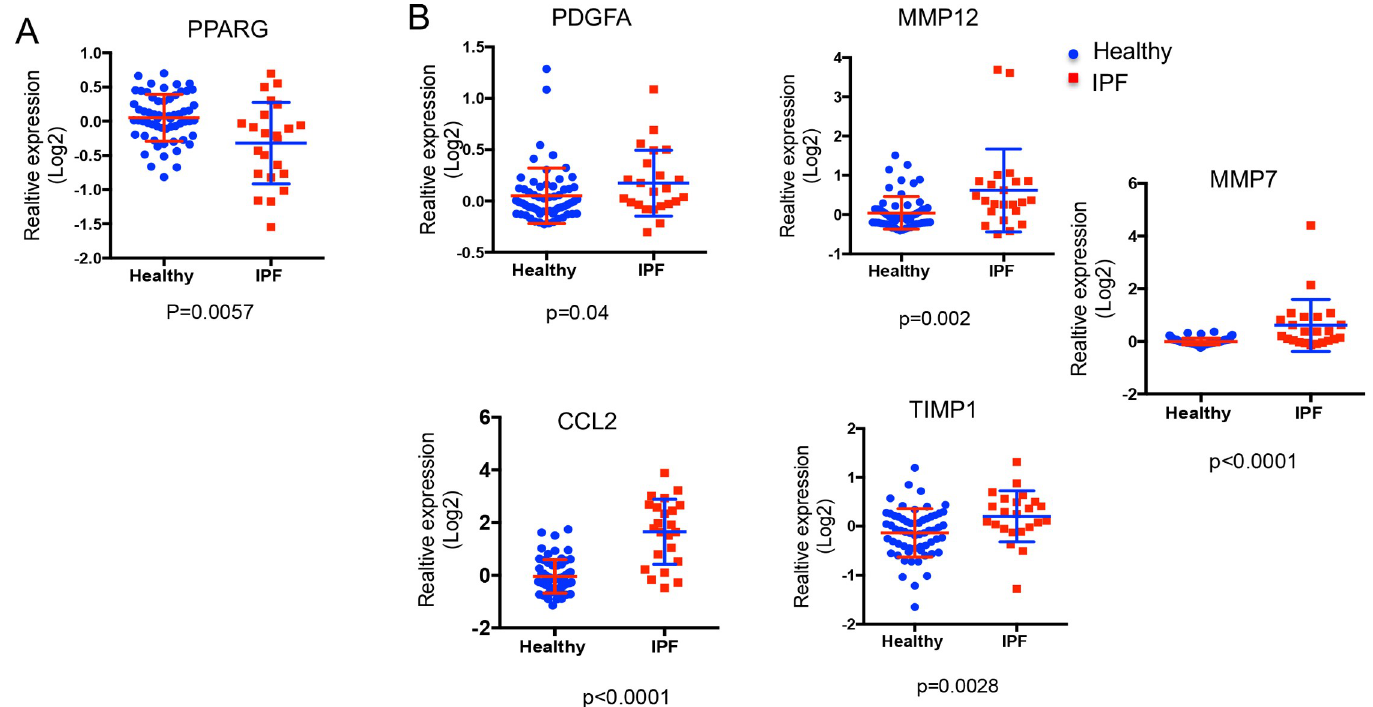
Fig 3. Macrophages from human pulmonary fibrosis patients exhibited diminished PPARG and dysregulated pro-inflammatory and pro-fibrotic gene expression. PPARG, pro-inflammatory and pro-fibrotic gene expression in lung macrophages isolated from 61 healthy volunteers or 23 pulmonary fibrosis patients in the GSE49072 microarray datasets. ( A ) PPARG expression in lung alveolar macrophages from healthy or pulmonary fibrosis patients. ( B ) MMP7, MMP12, TIMP1, CCL2 or PDGFA expression in lung alveolar macrophages from healthy or pulmonary fibrosis patients. Statistical values are indicated (two-tailed Mann-Whitney test).